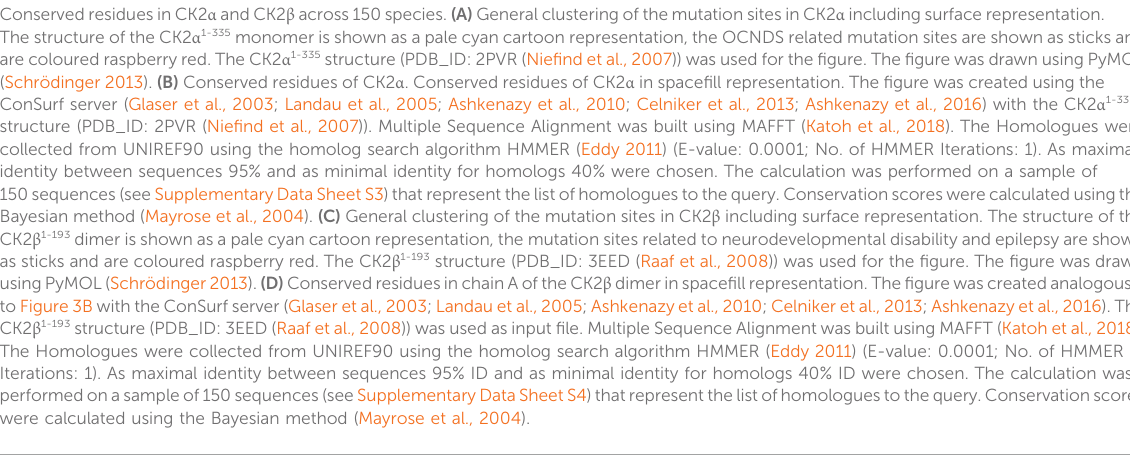
to Figure 3Bwith theConSurf server(Glaseretal., 2003;Landau et al.,2005;Ashkenazyetal., 2010;Celniker etal., 2013;Ashkenazy etal.,2016). The CK2 β 1-193 structure (PDB_ID: 3EED (Raaf et al., 2008)) was used as input fi le. Multiple Sequence Alignment was built using MAFFT (Katoh et al.,